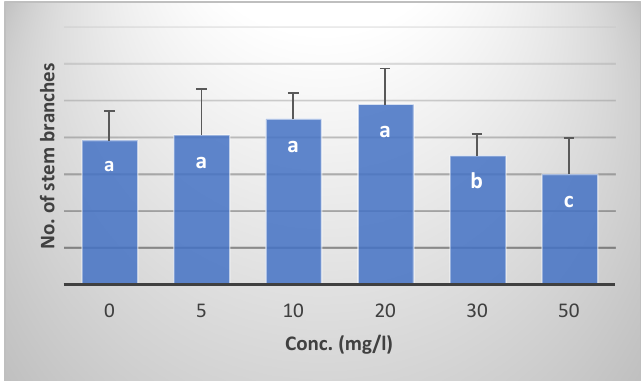
Figure 1. Number of stem branches of Cajanus cajan grown in soils treated with SA at different concentrations Different alphabet (a-c) means results are significantly difference at (P=0.05).